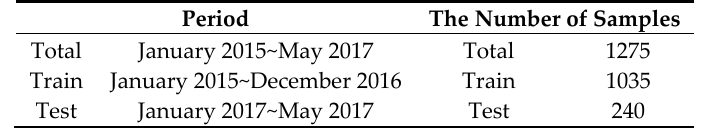
Table 1. Period and the number of samples for the data on electric charging stations